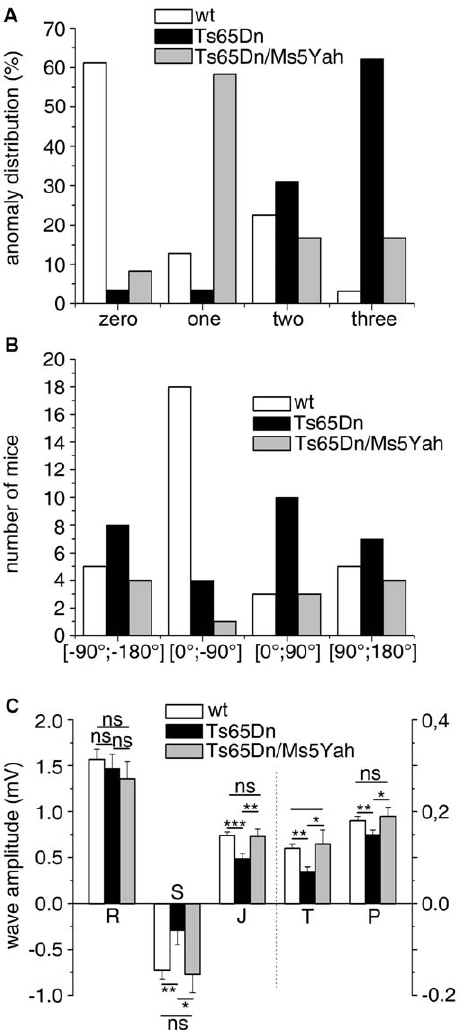
Figure 3. Partial rescue of ECG features in Ts65Dn/Ms5Yah compound mice. (A) ECG features from urethane anaesthetized adult mice were classified according to the presence of fragmented QRS (RSR’S’), slurr and S wave absence (Vx . 0) in the precordial leads. 62% of the Ts65Dn mice showed 3 anomalies while 61% of the wt was free of such features. Only 16% of Ts65Dn/Ms5Yah mice exhibited 3 anomalies and 65% had none or only one anomaly. (B) In the frontal plane, the electrical axis of both Ts65Dn and Ts65Dn/Ms5Yah animals were evenly distributed while that of wt showed a leftward preferential orientation. (C) wt, Ts65Dn and Ts65Dn/Ms5Yah ECG wave amplitudes were recorded in the precordial Vms lead. P, S, J and T waves’ amplitudes were all reduced in Ts65Dn mice as compared to wt while R wave was not changed. Double transgenic mice (Ts65Dn/Ms5Yah) rescued these effects (Mean 6 sem with ANOVA p values ***: P , 0.001; **: P , 0.01; *: P , 0.05 for 29, 18 and 12 wt, Ts65Dn and Ts65Dn/Ms5Yah respectively).